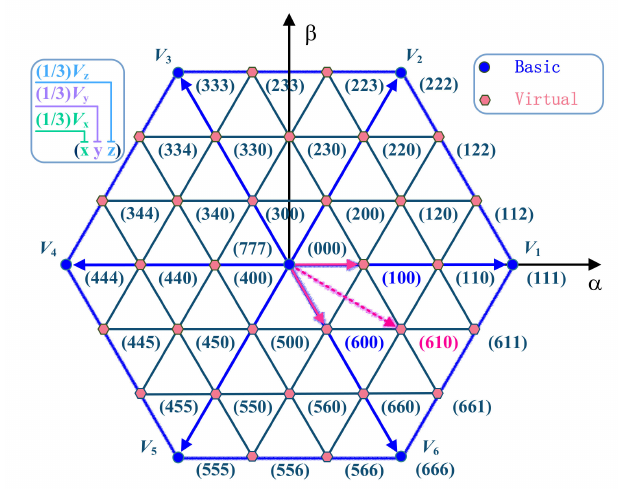
Figure 1. Distribution of basic and virtual voltage